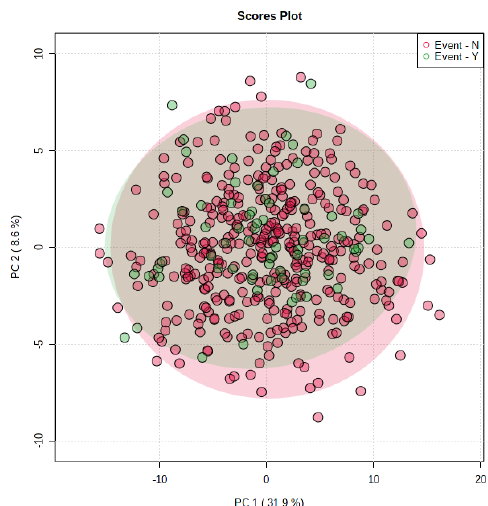
Figure 2. Principal component analysis plots derived from recurrent (green) and non-recurrent (red) colorectal cancer patients.